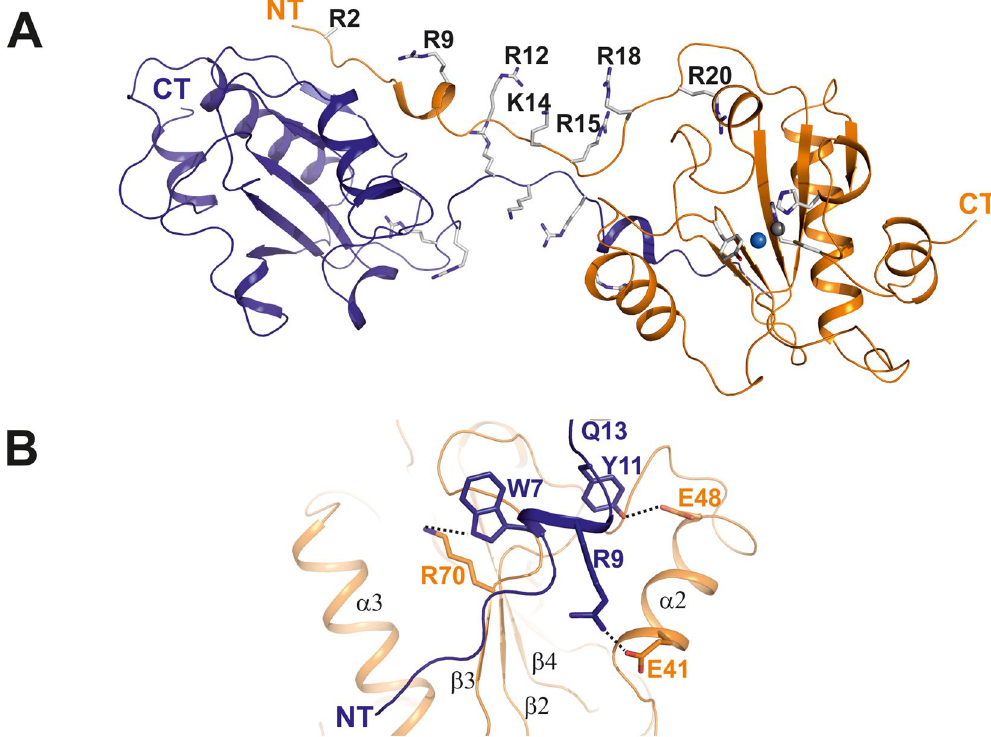
Figure 2. The dimeric structure of Ts2631 endolysin shows a 3D domain swap via the N-terminus. ( A ) Asymmetric unit of Ts2631 endolysin showing two protein molecules, which are highlighted in a ribbon representation. The dimer is interconnected by an elongated and largely unstructured N-terminus (residues 1–20), which carries seven positively charged residues (six arginines, one lysine; shown in stick representation), most of which are pointing towards the same direction (residues in stick representation are denoted by type and numbers). The structure represents a 3D domain swap of two interconnected monomers. ( B ) Molecular interactions between the N-terminus of monomer A (in blue) and the globular domain of monomer B (in orange) are marked by dashed lines. Interacting residues are marked in the same color as their respective domains and numbered according to their position in the sequence.